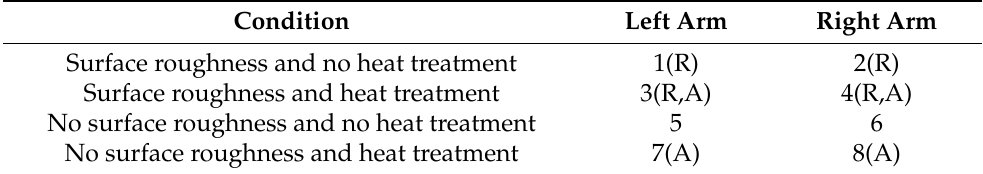
Table 1. The sample conditions for the samples from the left and right arm of the lattice.